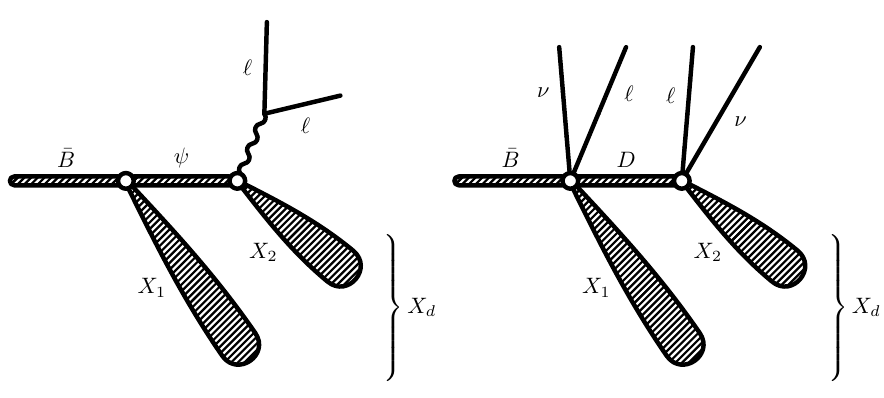
Figure 6 . Long distance backgrounds not removed by q 2 cuts. Left: charmonium cascade lowering q 2 to the perturbative window. Right: double semileptonic background through sequential weak decays.